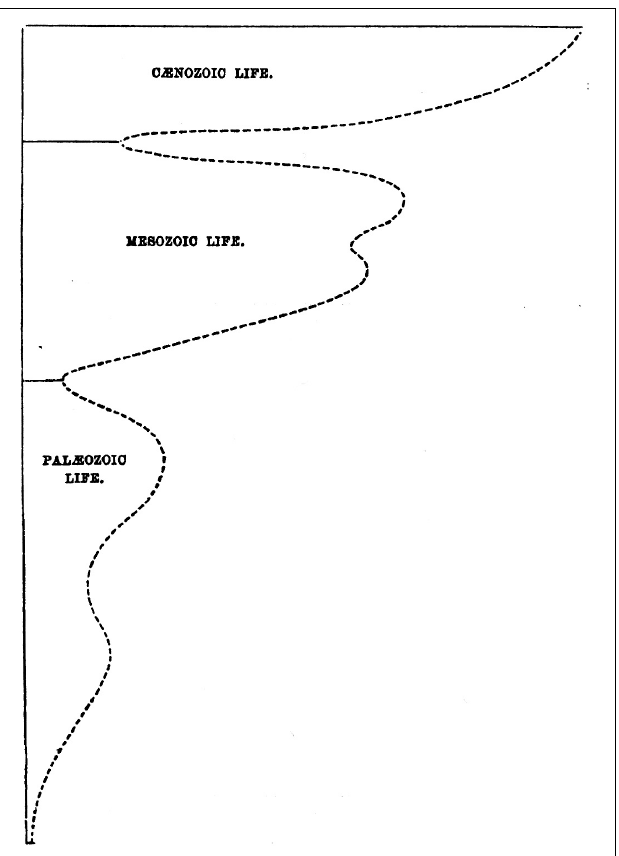
FIGURE 3 | Phillips (1860, p. 66; Figure 4 ) diagram that shows his basis for recognition of the Paleozoic, Mesozoic and Cenozoic eras, “which corresponds to the numerical prevalence of life and represents its rise and